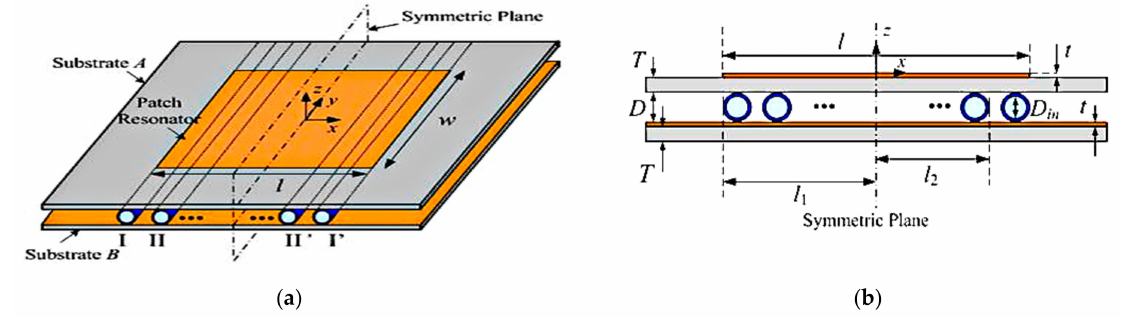
Figure 34. Microfluidic frequency reconfigurable patch antenna. ( a ) 3D view. ( b ) Side view